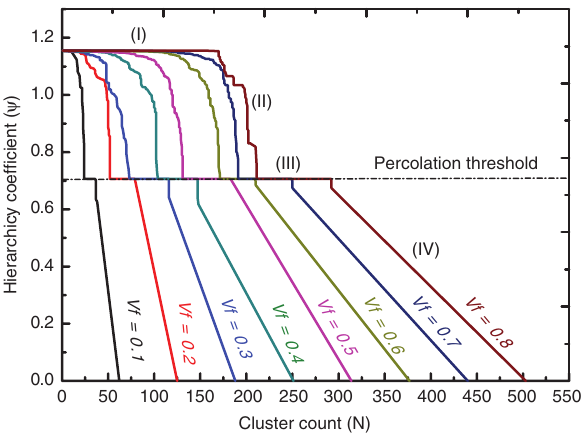
Figure 10: Plot between cluster count (N) generated vs. inconsist- ency coefficient ( Ψ ) for different volume fractions ( vf ).